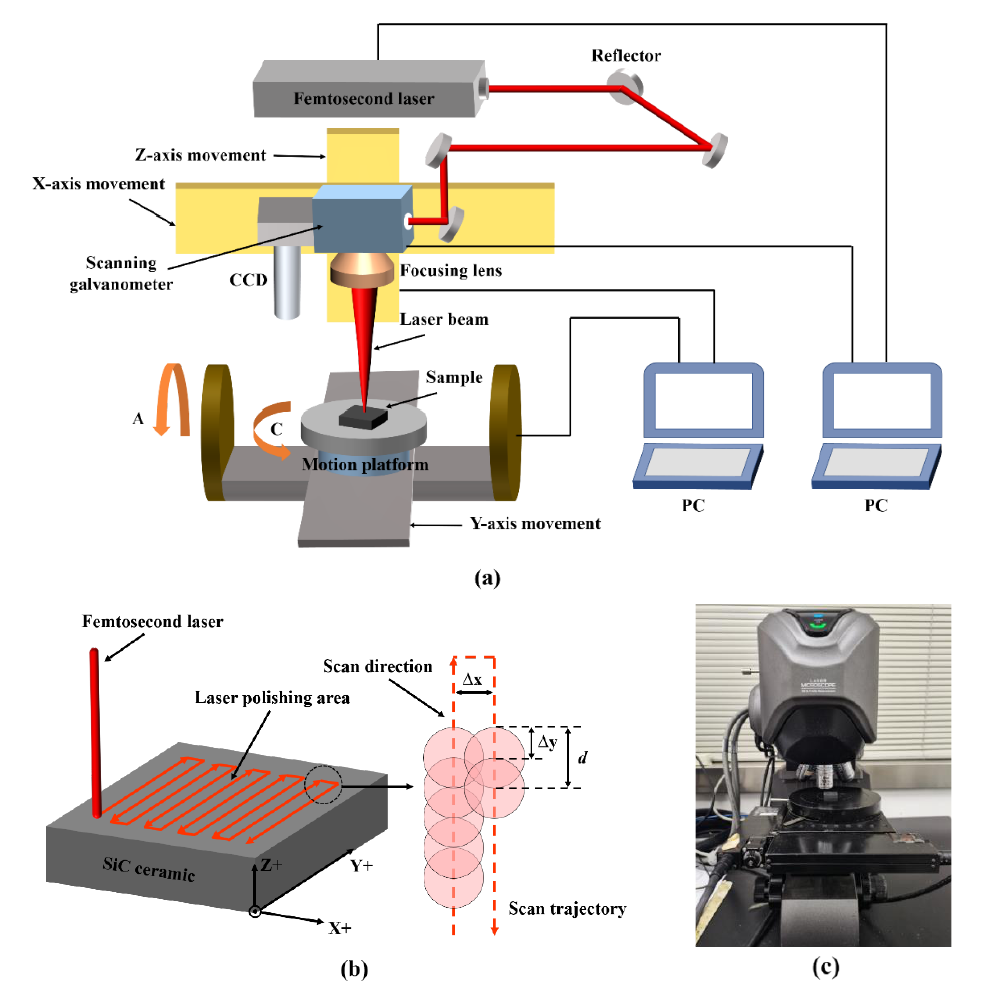
Figure 2. ( a ) The schematic diagram of infrared femtosecond laser processing system, ( b ) the schematic diagram of scanning trajectory and ( c ) the laser scanning confocal microscope.